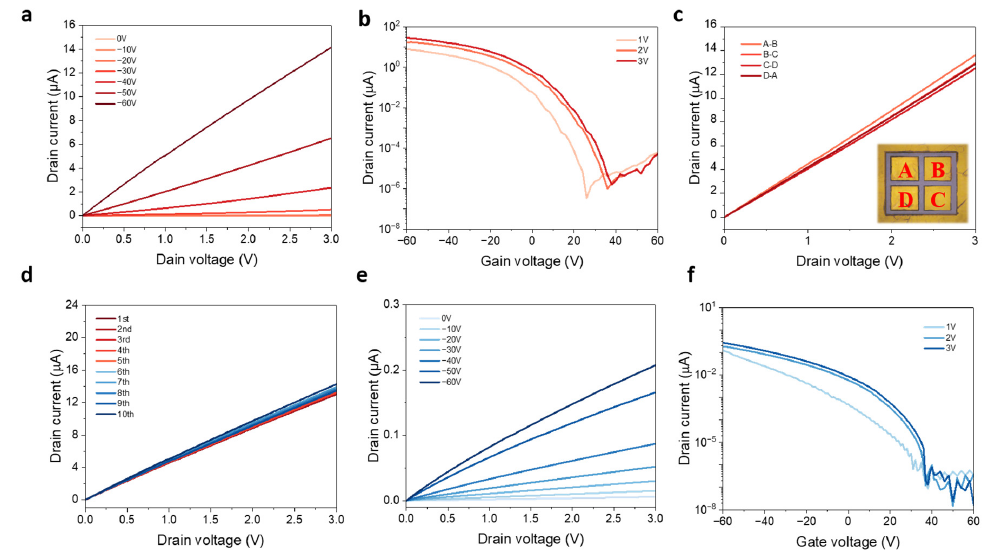
Figure 3. Electrical characteristics of the back-gate WSe 2 FETs with transfer-free method and con- ventional thermal deposition method. ( a ) I ds -V ds output curves and ( b ) I ds -V gs transfer curves of monolayer WSe 2 FETs using transfer-free method. ( c ) I ds -V ds output curves of transfer-free devices measured between adjacent Au electrodes. ( d ) I ds -V ds output characteristics of transfer-free devices measured within several weeks. ( e ) I ds -V ds output curves and ( f ) I ds -V gs transfer curves of monolayer WSe 2 FETs with Au electrodes thermally deposited.